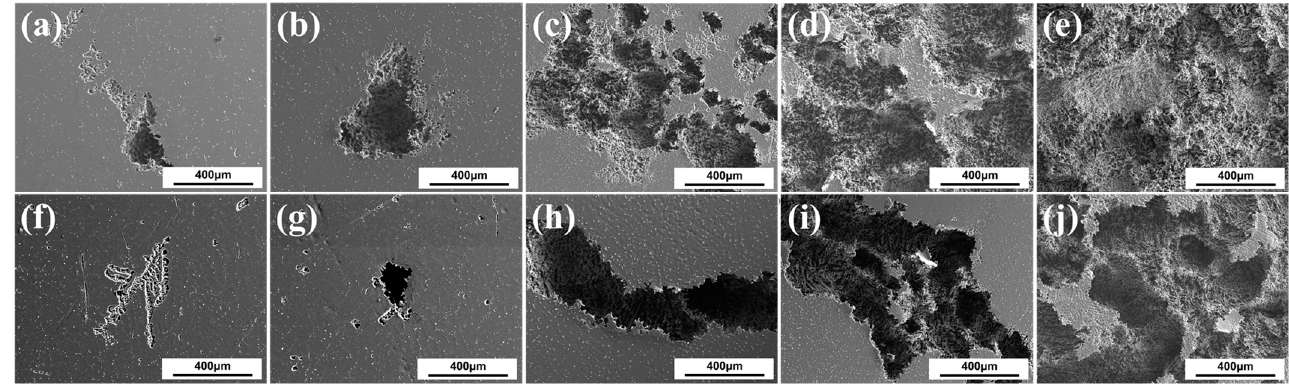
Figure 3. SEM observation of ( a – e ) GC AM60 alloy and ( f – j ) GC AMXW6000 alloy by immersion after 1 h, 3 h, 12 h, 2 days, 8 days, respectively.